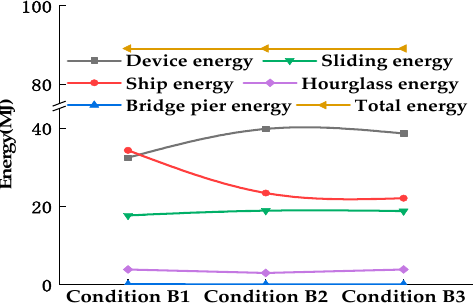
Figure 20. Energy comparison and summary of the three different wall thicknesses under protected conditions.